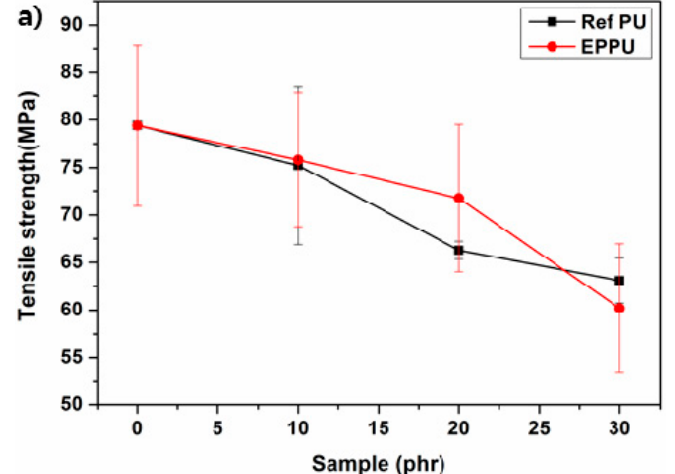
Figure 7. TGA data for Ref PU and EPPU in air. Table 2. Thermal degradation temperatures of polyurethanes obtained with thermogravimetric analysis (TGA) (N 2 ).